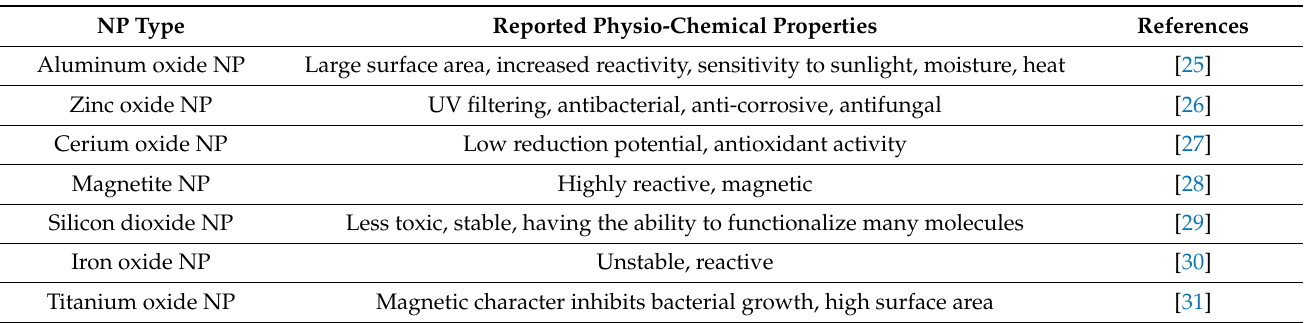
Table 2. Classification of metal oxide NPs and their physio-chemical